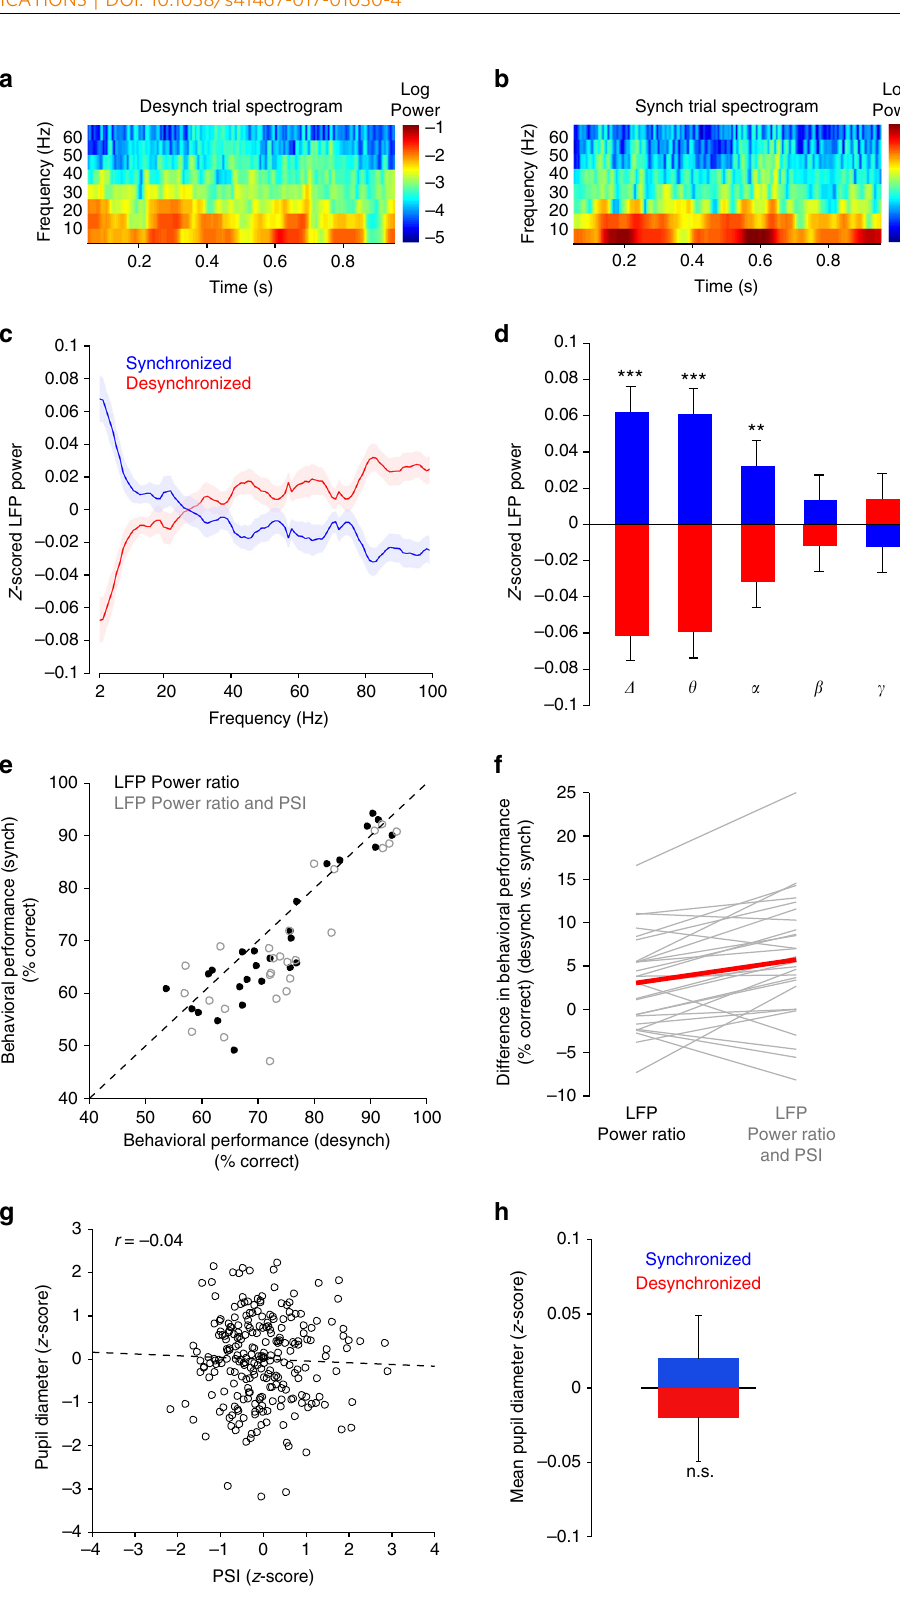
for 100 ms ( P = 0.078, paired t -test, n = 26 sessions). The fact that the neural and behavioral effects induced by population synchrony are somewhat diminished when using larger time bins indicates that a low-resolution PSI measure is not the ideal tool with which to explain the variability in neuronal